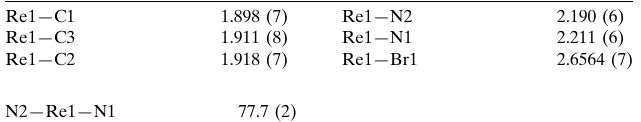
Selected geometric parameters (A˚ , (cid:1) ).